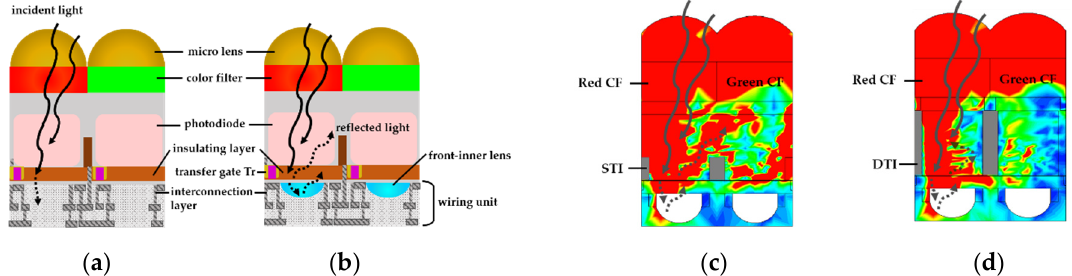
Figure 1. Pixel structures and beam profiles of power flux density. The incident light was a 650 nm wavelength. The solid line indicates the transmitted light from the micro lens and color filter. The dotted line shows the reflected light from the front-inner lens: ( a ) The incident light with the typical structure was not fully absorbed in the photodiode; ( b ) the incident light with the proposed structure was reflected and absorbed in the photodiode; ( c ) the proposed structure with shallow trench isolation (STI), and ( d ) the proposed structure with deep trench isolation (DTI).